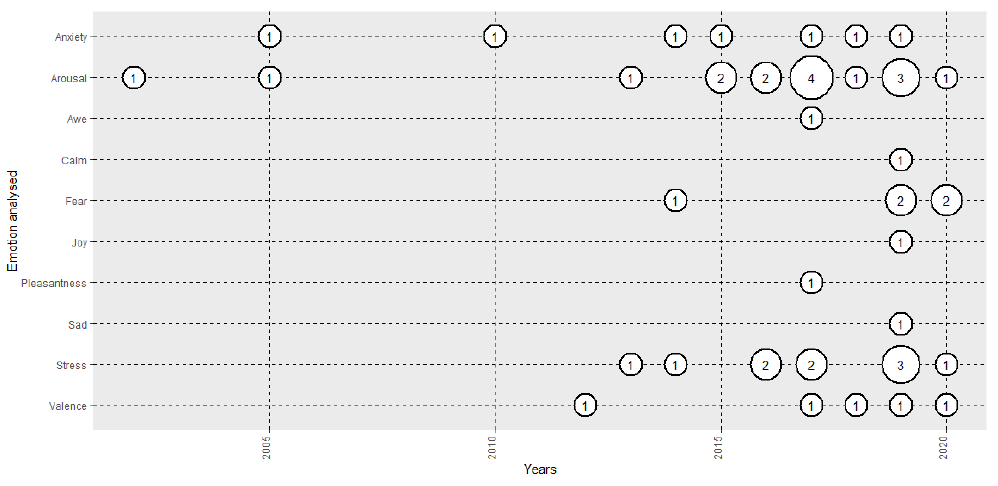
Figure 3. Evolution of the number of papers published each year based on emotion analysed.